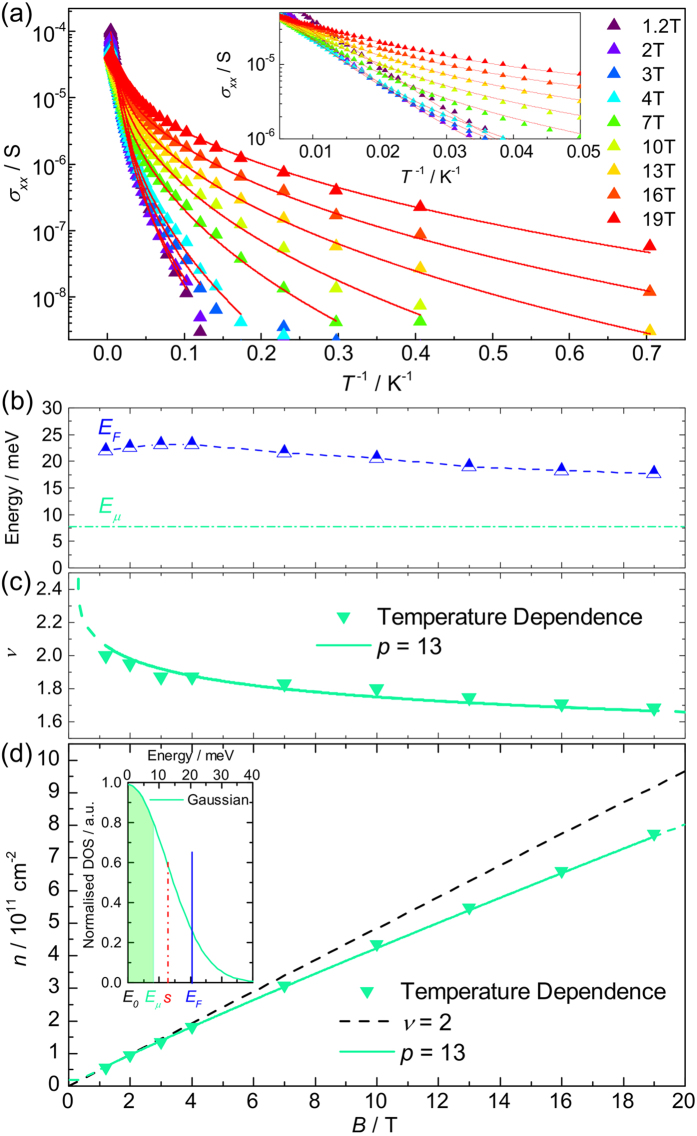
Temperature dependent magneto-conductivity.(a) Longitudinal conductivity as a function of temperature from 1.4 to 200 K at various magnetic fields. Red solid lines are fits as described in the text. Inset: high temperature regime from 20 to 200 K. (b) EF and Eμ as a function of magnetic field. (c,d) Magnetic field dependence of the filling factor ν and the carrier density n extracted from the temperature dependence analysis (green triangles), and best fits (solid lines) with their extrapolation (dashed lines) using equation (6) with the power p = 13. Inset: the Gaussian DOS used in the temperature dependence analysis with characteristic energy levels marked.